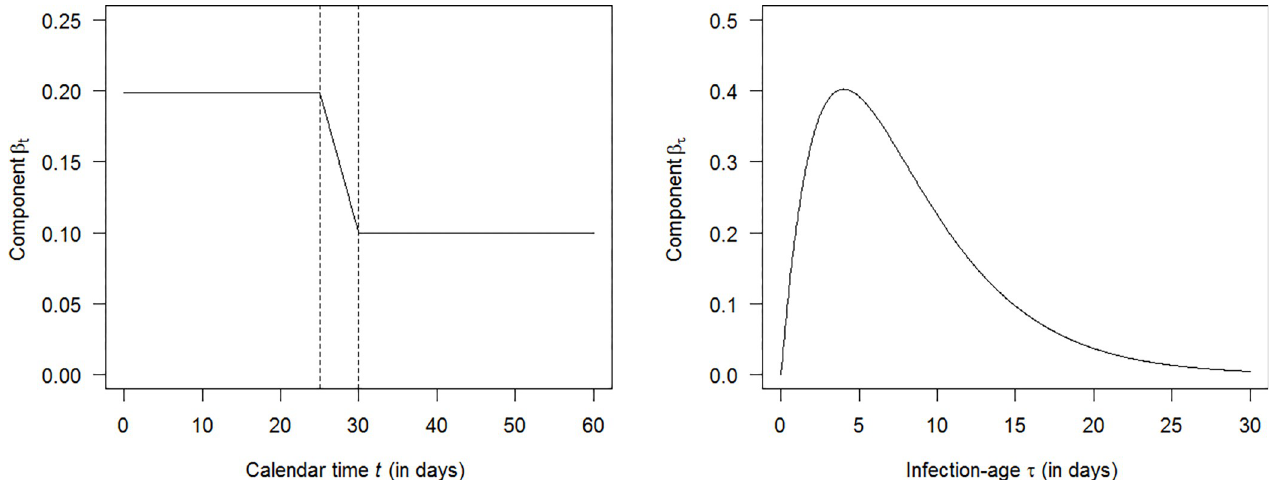
Fig 2. Components of the transmission rate β . The left panel shows the time dependent part β t of the transmission rate β during three phases of the pandemic: before lockdown at t = 25 (days), installation of lockdown (from t = 25 to t = 30, between vertical dotted lines) and control of the disease ( t > 30). The right panel shows the component β of the transmission rate β as a function of the infection age τ . More details can be found in Section 4 of the S1 File. τ